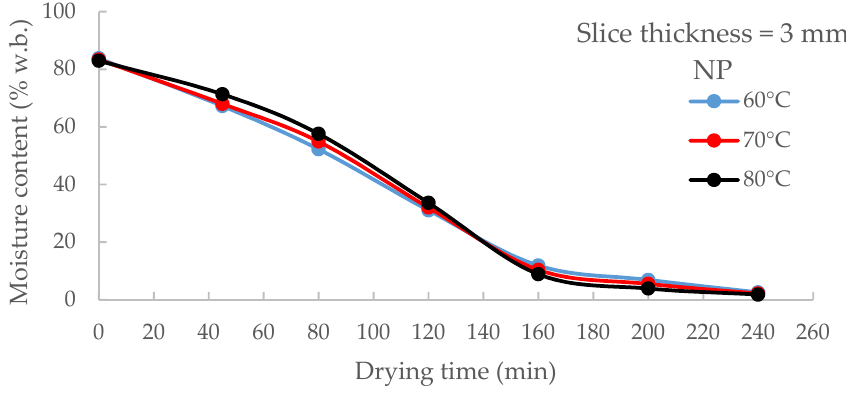
Figure 1. Effect of drying air temperature on drying time of non-pre-treated (NP) quince fruit. Denge [33] discovered that raising the drying air temperature in the oven and vac- uum drying the quince reduced the drying time. Microwave drying time was 10 min at 750 W and 240 min at 100 W, hence raising the power level lowered drying time. Aktas et al. [34] found the lowest drying time as 240 min by infrared drying at drying conditions of 40 °C and 1.22 m/s, while the longest drying time was approximately 390 min at 35 °C and 2.45 m/s. Abbaspour-Gilandeh et al. [35] employed convective drying and discovered that at lower drying air temperatures, the overall drying time was longer. Szychowski et al. [36] used convective (CD), vacuum–microwave (VMD), freeze drying (FD) and combi- nation drying (CDVMFD) procedures. The drying time was lowered from 300 to 240 min by raising the air temperature in CD from 50 to 70 °C. The drying time in VMD was re- duced from 120 to 34 min by increasing the microwave power from 120 to 480 W. Increas- ing temperature from 50 to 70 °C reduced the entire drying time in the CDVMFD process from 135 min to 112 min. Celen and Kus [37] found that microwave power level affected the drying process according to the findings; increasing the power level increased the moisture loss and reduced drying time. The drying times were 39, 95 and 57 min at 2000 W and 39, 50 and 36 min at 2800 W, respectively, for the aforementioned belt velocities. Tzempelikos et al. [38] investigated convection drying of 12 mm quince slices. Raising the temperature from 40 °C to 50 °C reduced drying time by about 25%, from 50 °C to 60 °C reduced the drying time by about 36%, and from 40 °C to 60 °C reduced overall drying time by about 54%. Tzempelikos et al. [39] studied convective drying of quince slices at varied drying air temperatures, bulk velocity, drying air velocity and relative humidity. According to the statistics, the drying air temperature had a significant impact on the dry- ing time. Increasing the drying air temperature from 40 to 60 °C cut the overall drying time in half. Karaaslan et al. [40] dried quince slices (5 mm) by microwave–convective dryer. The researchers discovered that increasing the microwave power level lowered the drying time. Drying times were 104, 39, 24, 22 and 12 min at 180, 360, 540, 720 and 900 W microwave power levels, respectively. To dry quince cubes, Izli and Polat [41] utilized convection drying. It took 120, 90, 70 and 50 min at 45, 55, 65 and 75 °C, respectively. As a result, the drying time was significantly reduced as the temperature rose. Kaya et al. [42] dried quince slices (4 mm) at drying air temperatures of 35, 45 and 55 °C, velocities of 0.2, 0.4 and 0.6 m/s, and relative humidities of 40, 55 and 70%. According to the findings, rais- ing the drying air temperature or velocity and decreasing relative humidity lowered over- all drying time. When the drying air temperature increased from 35 to 55 °C, the overall drying time was lowered by 55 percent. After osmotic drying by concentrated fruit juice solutions at 40 Brix, Turkiewicz et al. [43] dried quince cylinders by convective drying and found the drying time to be between 360 to 480 min. When the lowest drying temperature was used, the longest drying time was obtained. Turkiewicz et al. [44] evaluated a con- vective, vacuum–microwave, a combination of convective pre-drying and vacuum-micro-